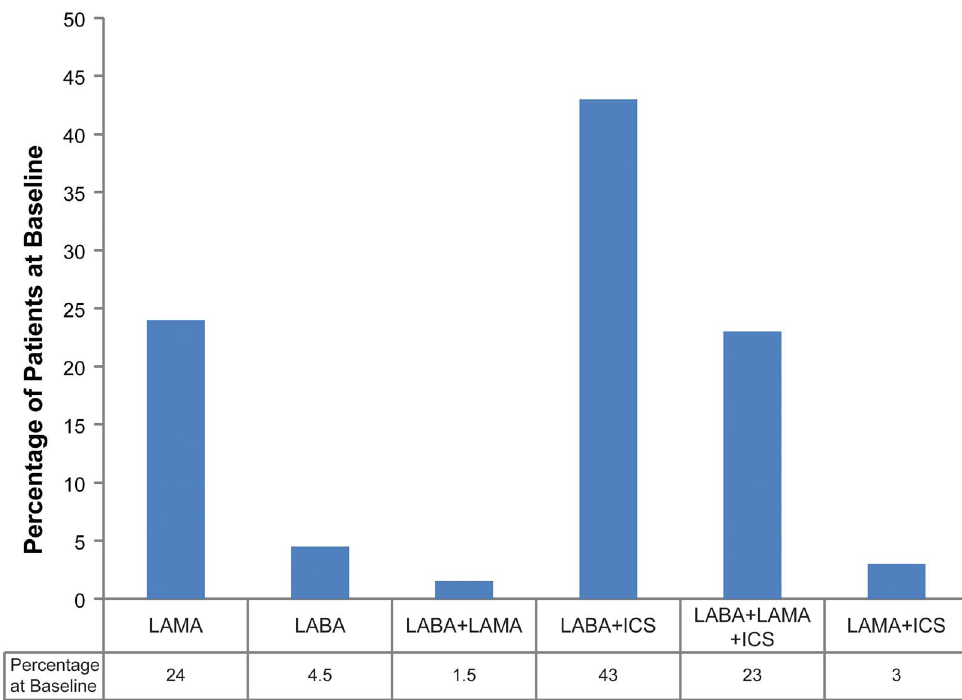
Figure 1. Maintenance prescriptions at diagnosis. Patients (n=3199) prescribed maintenance therapy at baseline and 3–6 months excluding patients with no treatment, SABD alone, ICS, and others. Abbreviations: ICS, inhaled corticosteroid; LABA, long-acting b 2 -agonist; LAMA, long-acting muscarinic antagonist.